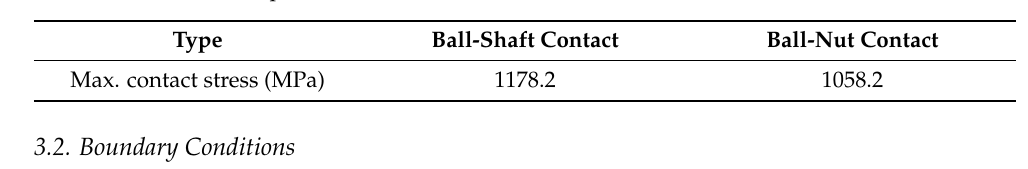
Table 3. Maximum compressive stress.